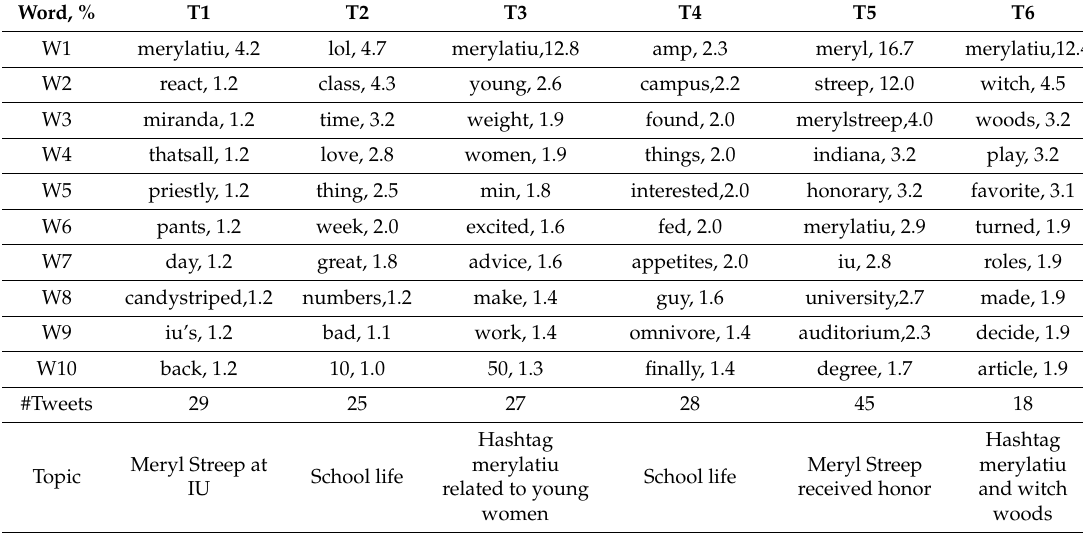
Table 5. Modeled topics of Meryl Streep’s visit to Indiana